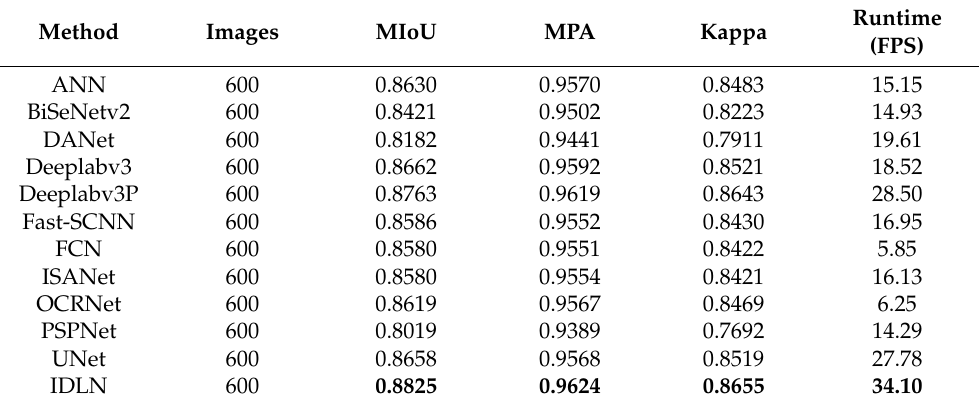
Table 4. Comparison of performance indicators of the 11 models on the left and right eye data.